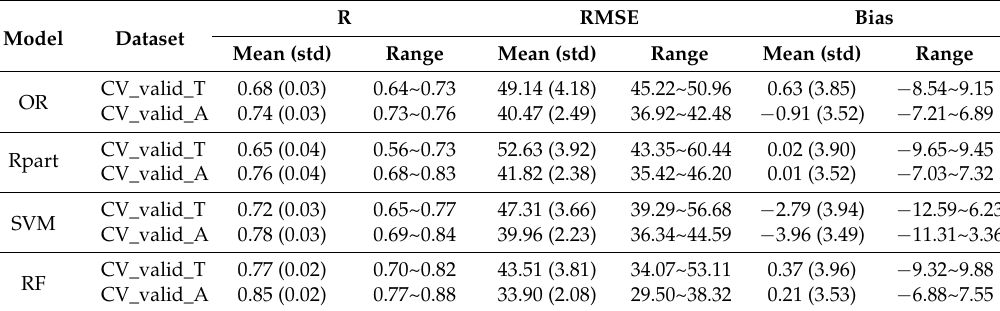
Table 1. The statistical results of the cross-validation (CV) validation set for Orthogonal Regression (OR), Regression Tree (Rpart), Support Vector Machine (SVM) and Random Forest (RF)